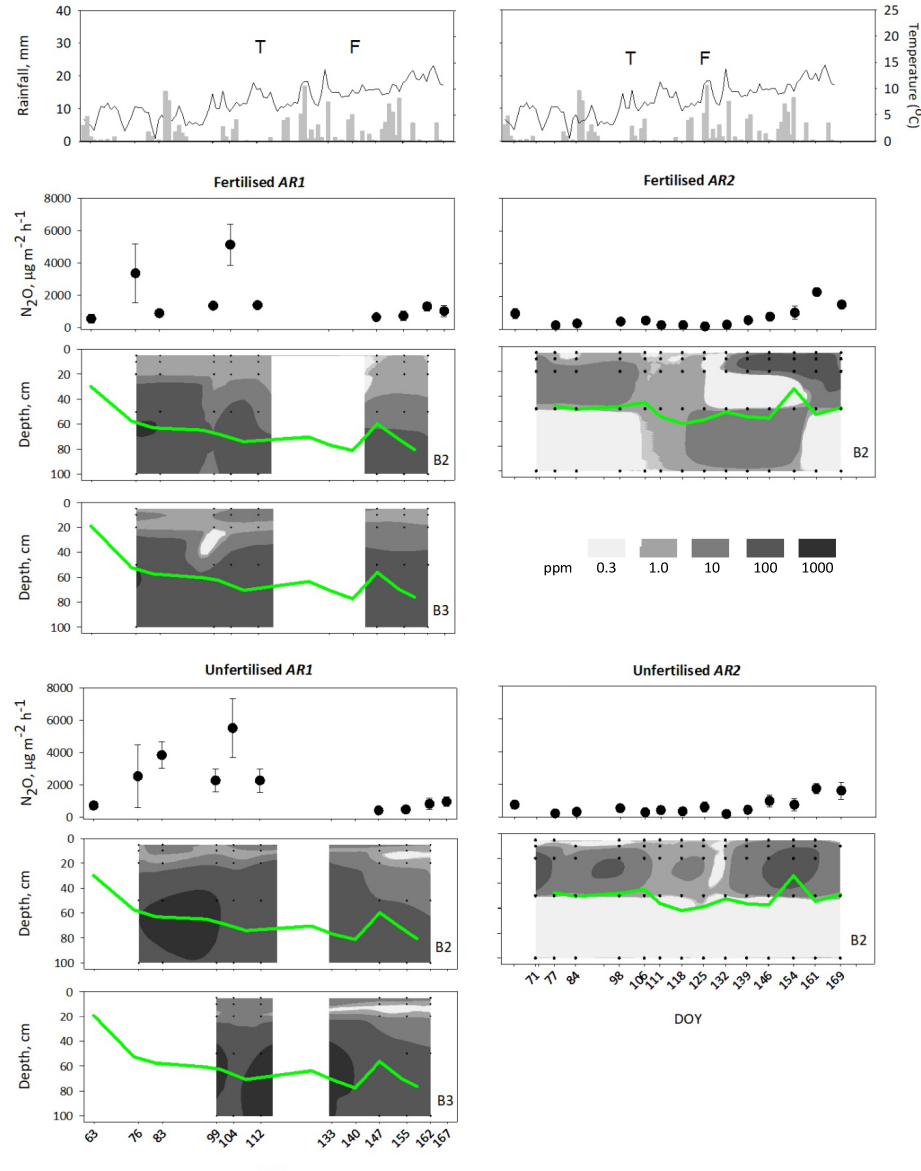
Figure 4. The top panel shows rainfall, air temperature and management ( T – tillage; F – fertilisation) at AR1 (left panels) and AR2 (right panels) during spring, 3 March (DOY 63) to 16 June (DOY 169). The middle section shows N 2 O fluxes (black circles; mean ± standard error, n = 3) and contour plots of soil N 2 O concentrations in fertilised subplots, and the lower section shows the corresponding results for unfertilised subplots. A logarithmic grey scale was used in order to show trends within both RG and AR treatments and between depths. Soil gas sampling positions are indicated in the contour plots; numbers shown are N 2 O concentrations (µLL − 1 ). Gaps are indicated where soil gas sampling probes were installed late or removed due to field operations. Green lines show the WT depth (which varied slightly between blocks). B2 and B3 refer to block number of diffusion probe